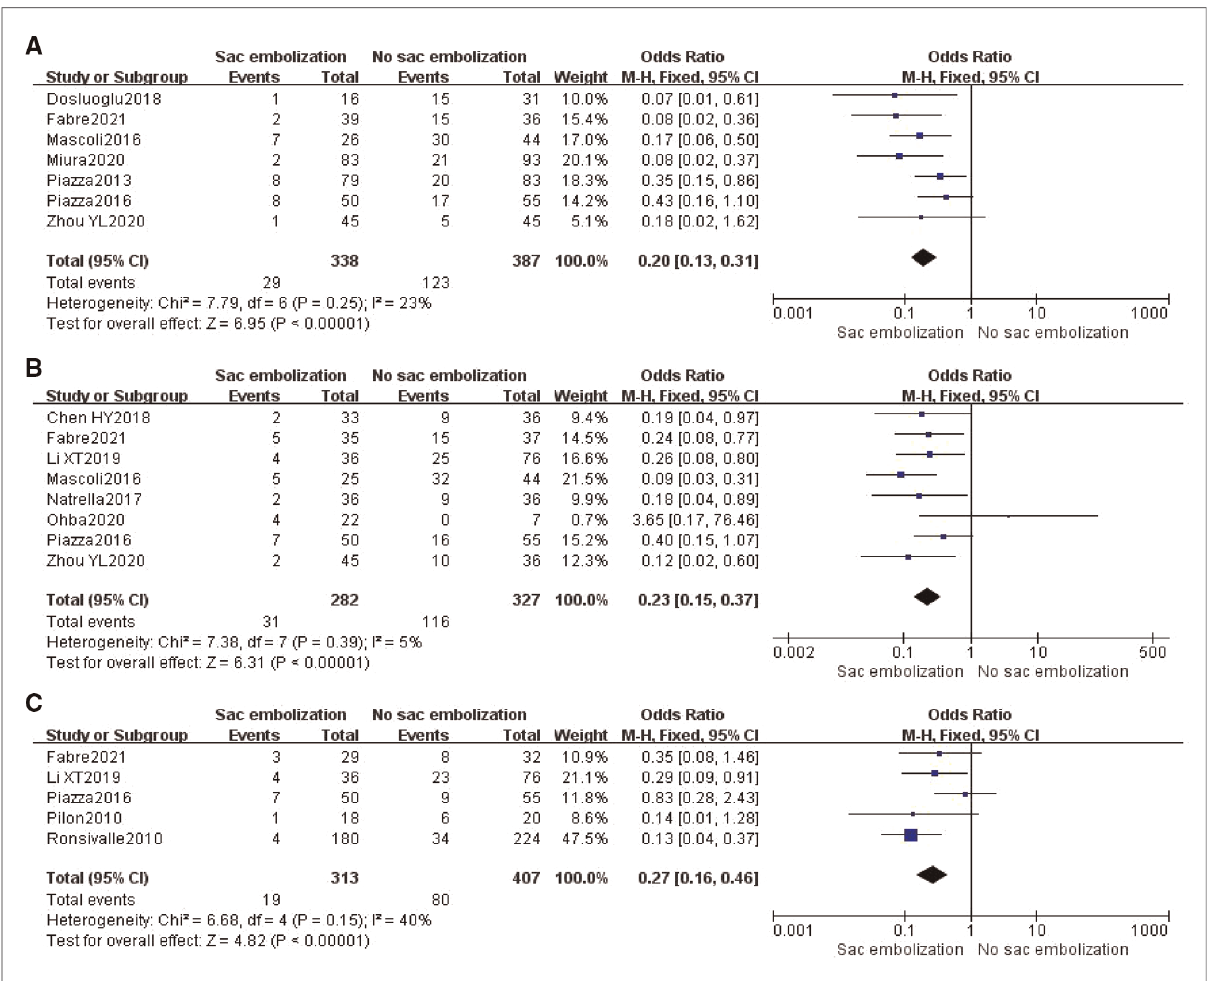
FIGURE 2 Incidence of early-term ( A ), mid-term ( B ), and late-term ( C ) type II endoleak in the embolization group compare with the non- embolization